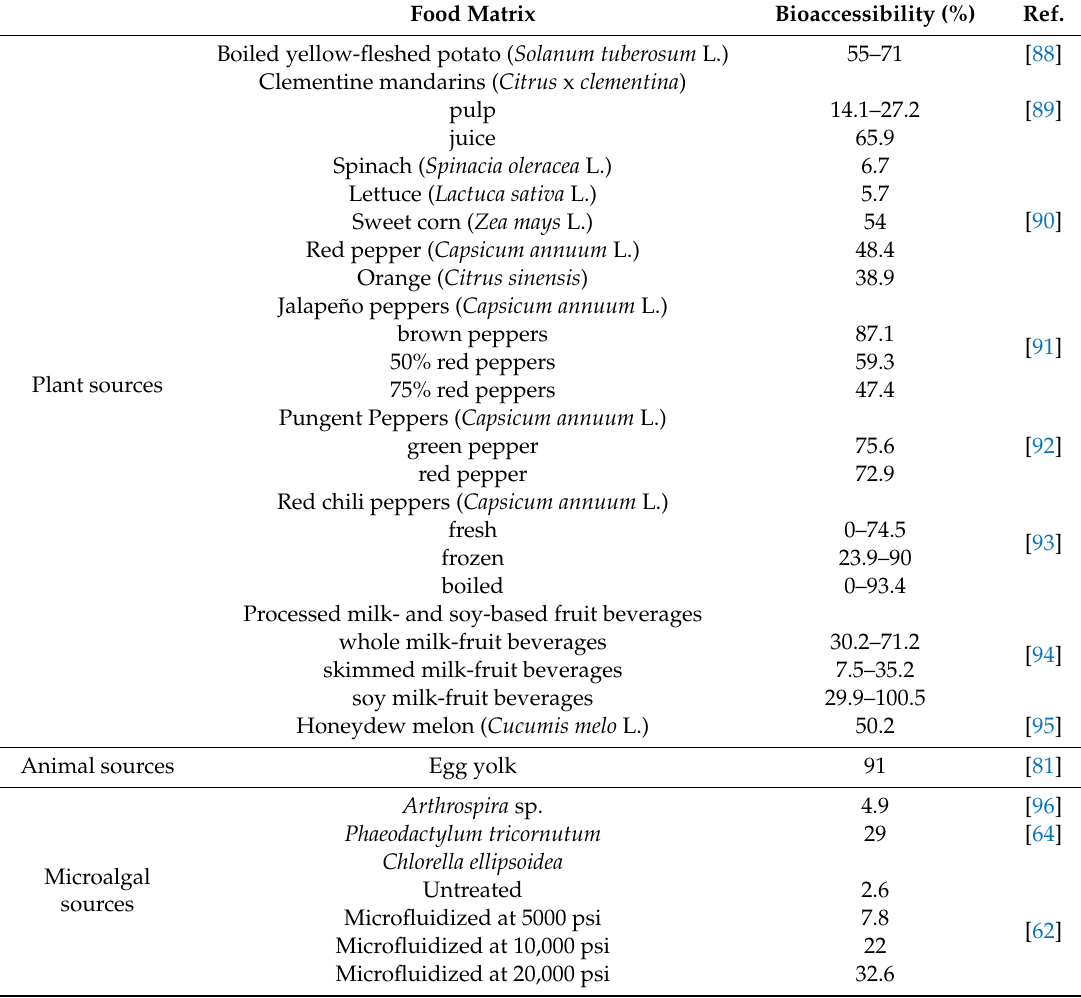
Table 3. Relevant research on zeaxanthin bioaccessibility (%) from di ff erent food sources assessed through various in vitro digestion